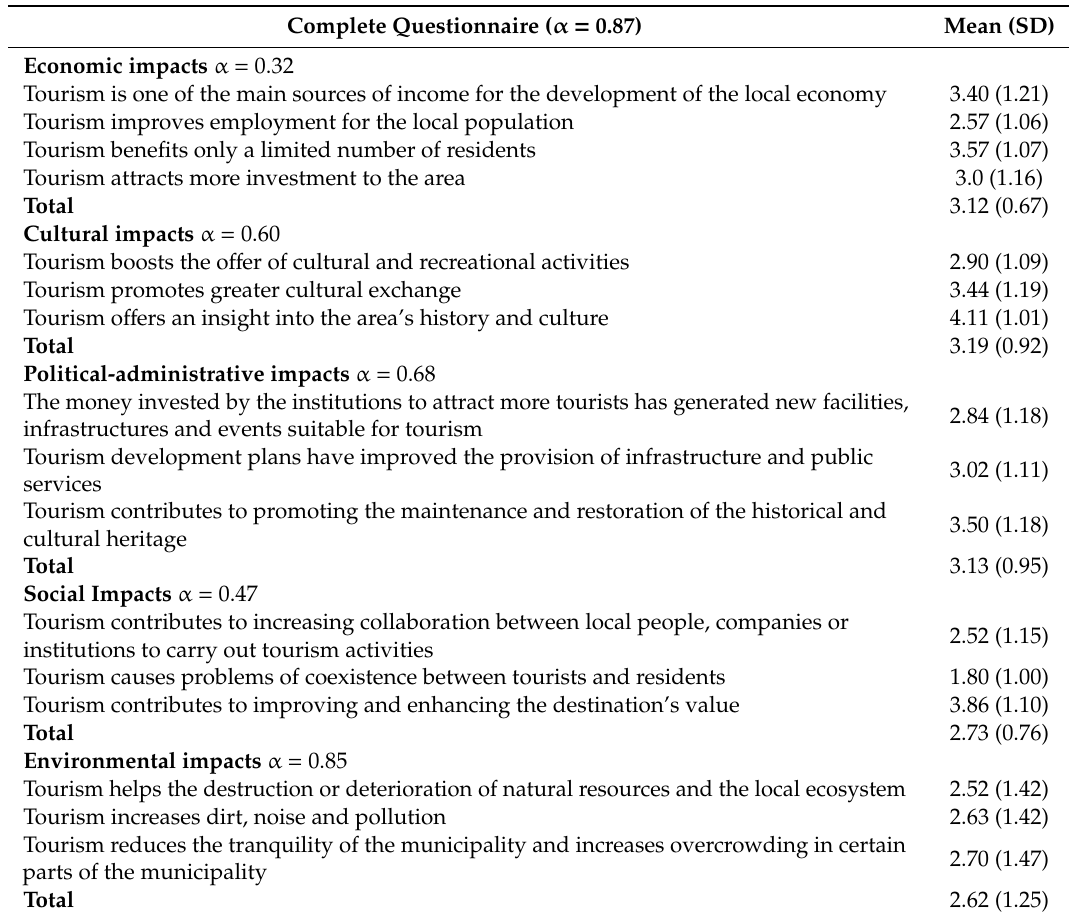
Table 3. Descriptive analysis: perception of the impacts of tourism Source: Author´s own. Complete Questionnaire ( α =